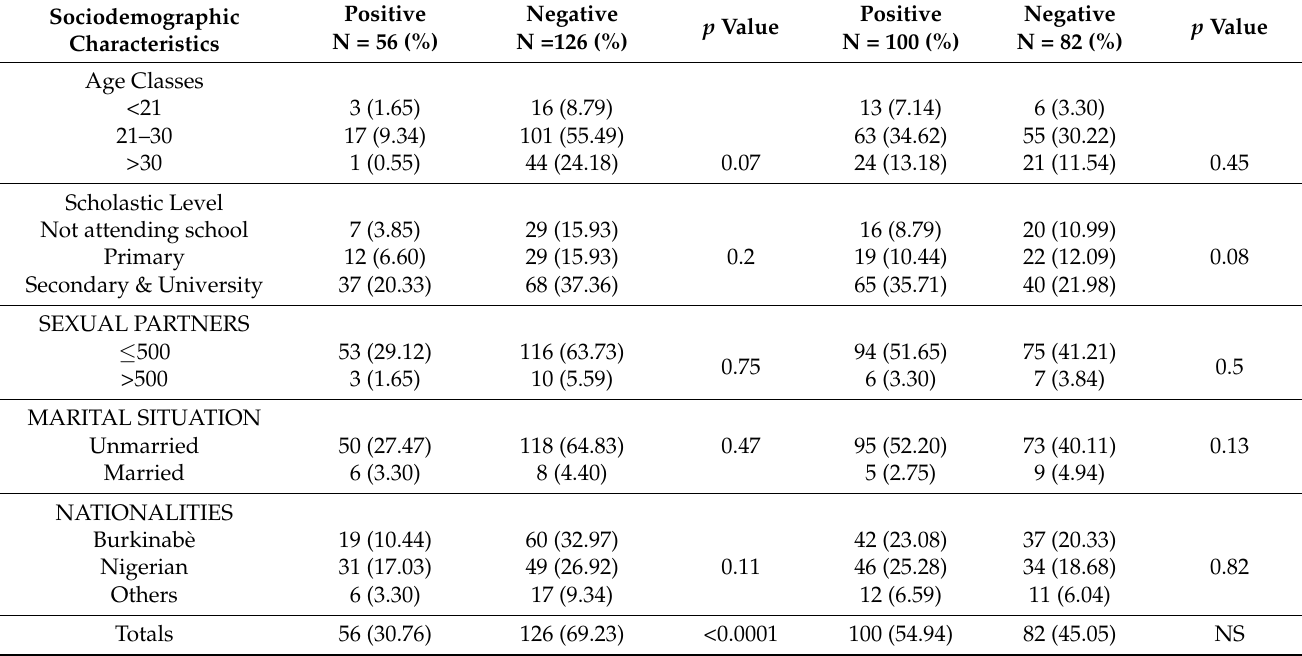
Table 2. Sociodemographic characteristics of the study population presented by identified pathogens.